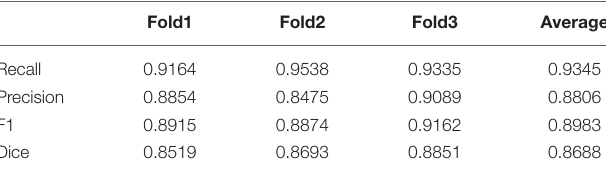
TABLE 3 | Evaluation of soma segmentation in GFP dataset captured by fMOST system.